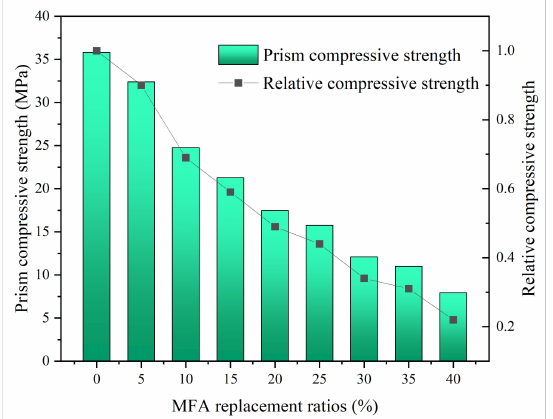
Figure 7. Prism compressive strength versus MFA replacement